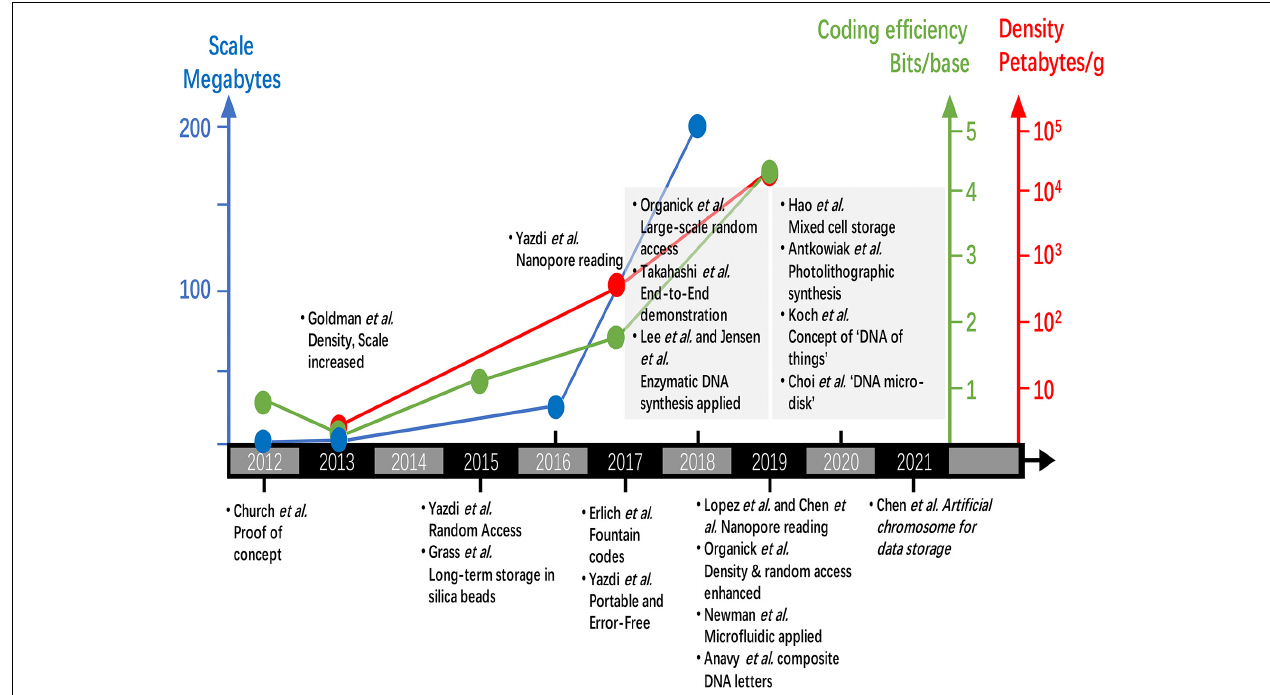
FIGURE 5 | Recent progress of data storage in DNA on data scale, coding efficiency, data density and novel